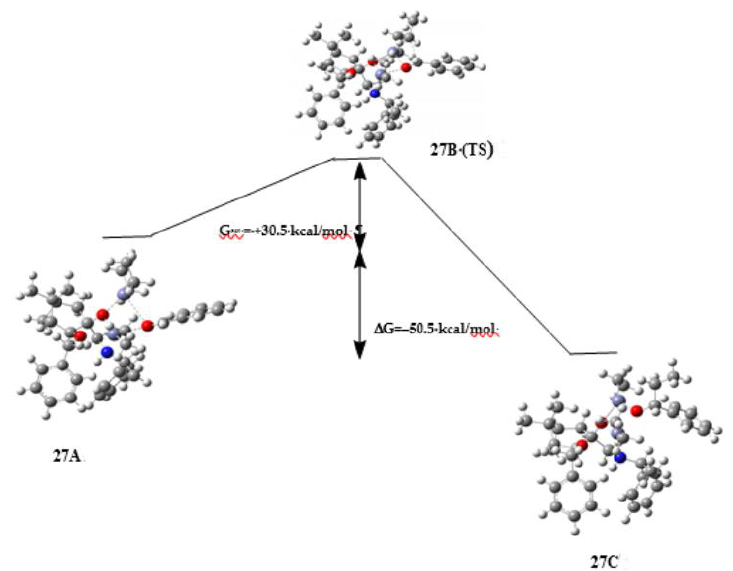
Figure 3. Reaction coordinate with activation barrier and thermodynamics of the ethyl transfer connecting complexes 27A and 27C via transition state 27B optimized by the HF / LANL2DZ method. All calculations were carried out by using Gaussian 09 software package [70]. The optimized structures are available from the